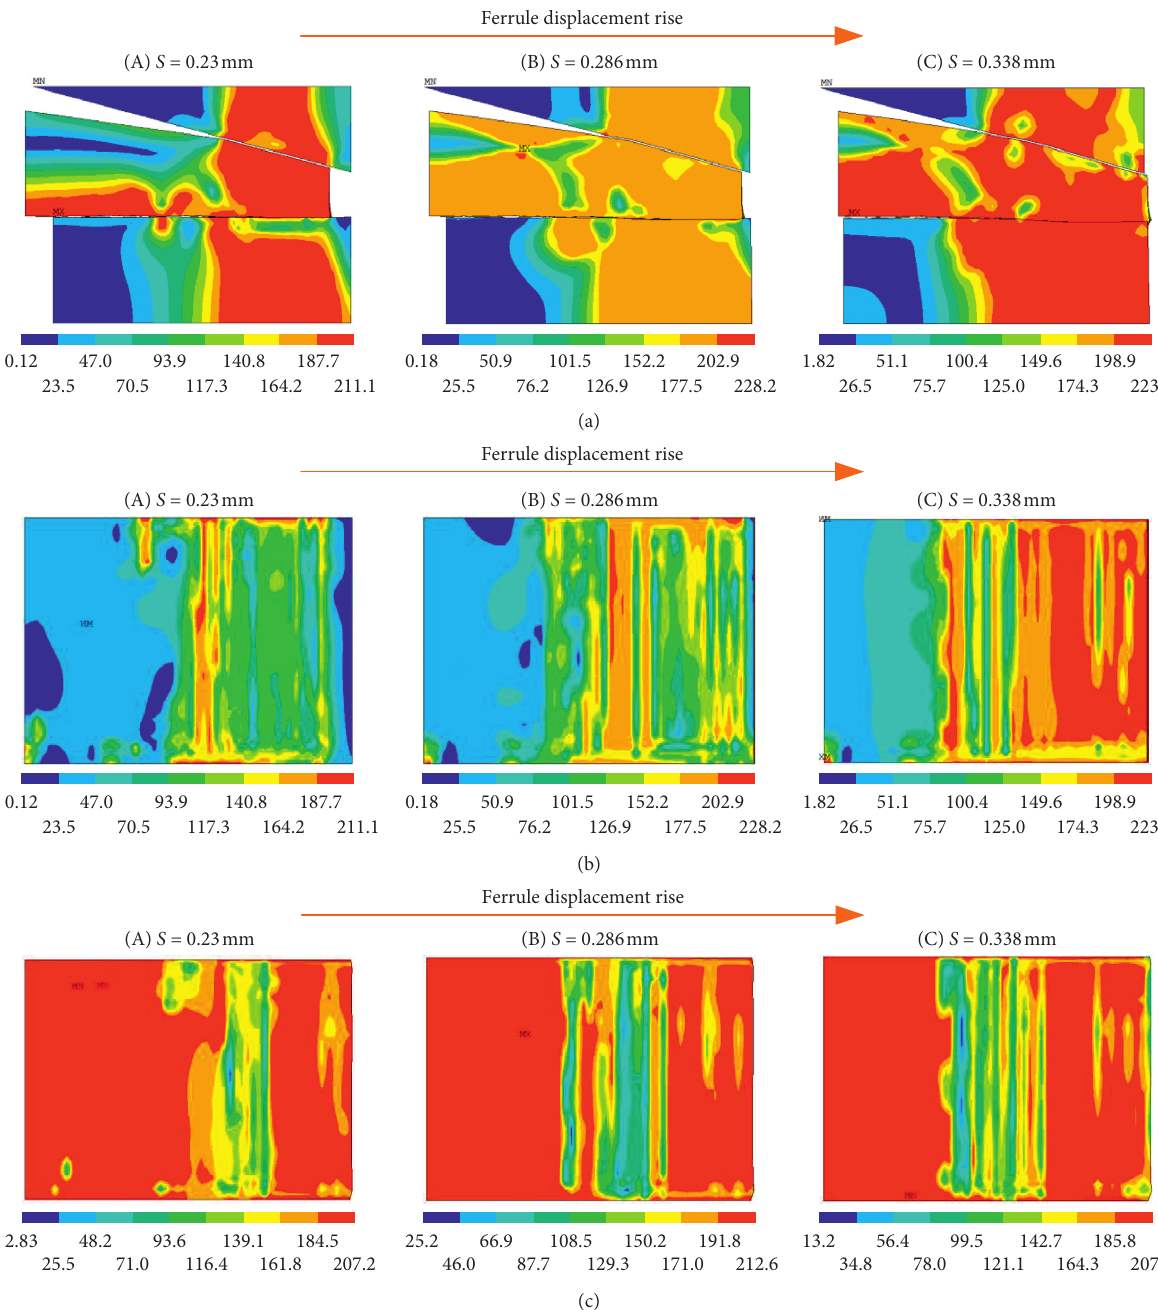
Figure 5: Sealing analysis of pipeline fittings during assembly. (a) Seal state of fittings. (b) Stress distribution of pipeline surface. (c) Stress distribution of ferrule